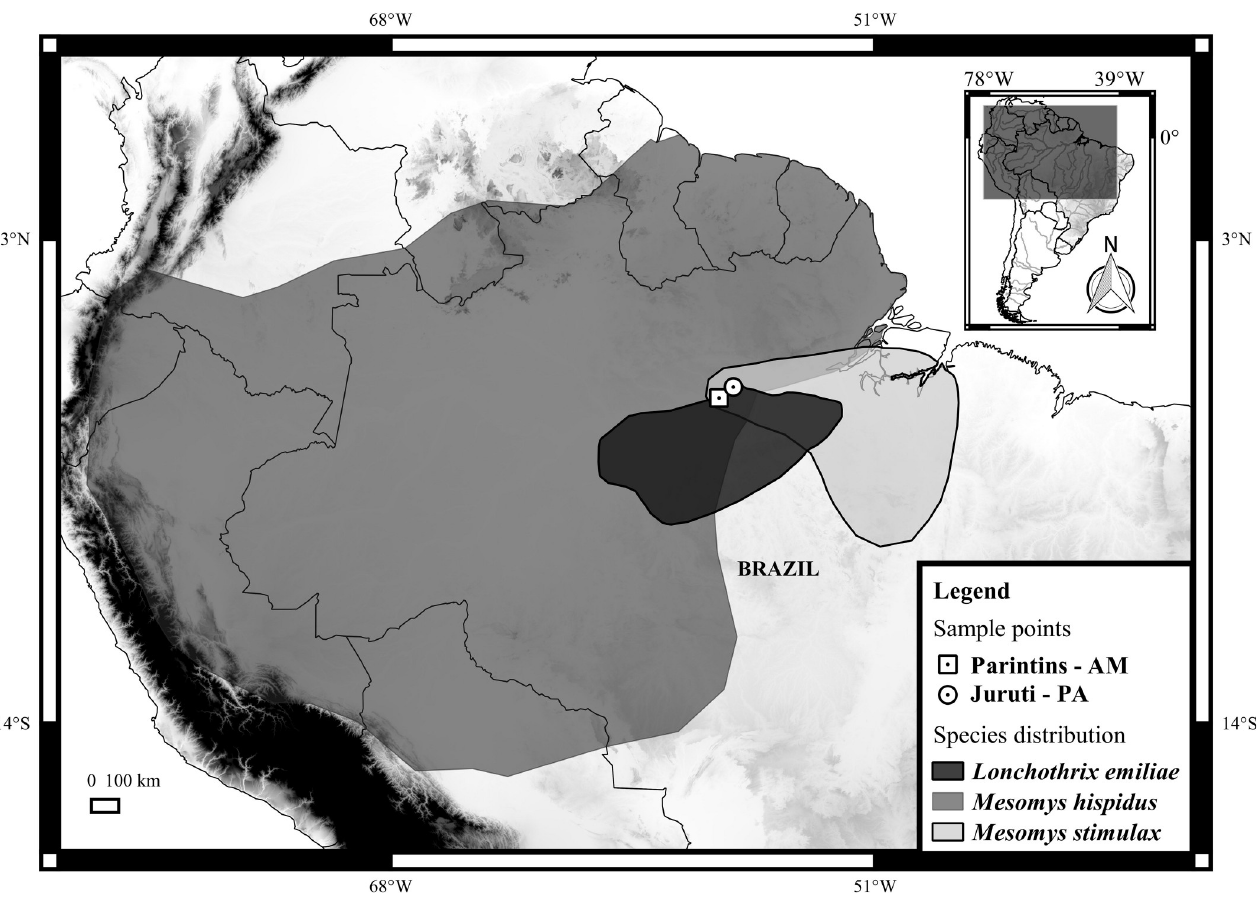
Fig 1. Geographic distribution of Lonchothrix emiliae , Mesomys hispidus , and M . stimulax , and the sampling sites for L . emiliae and M . stimulax . Parintins–AM (white square with black dot), Juruti–PA (white circle with black dot). The Brazilian states are Amazonas (AM) and Para´ (PA). The map was generated using QUANTUM-GIS software, version 3.6. Databases were obtained from DIVA-GIS [16], and IUCN (International Union for Conservation of Nature) [17–19].